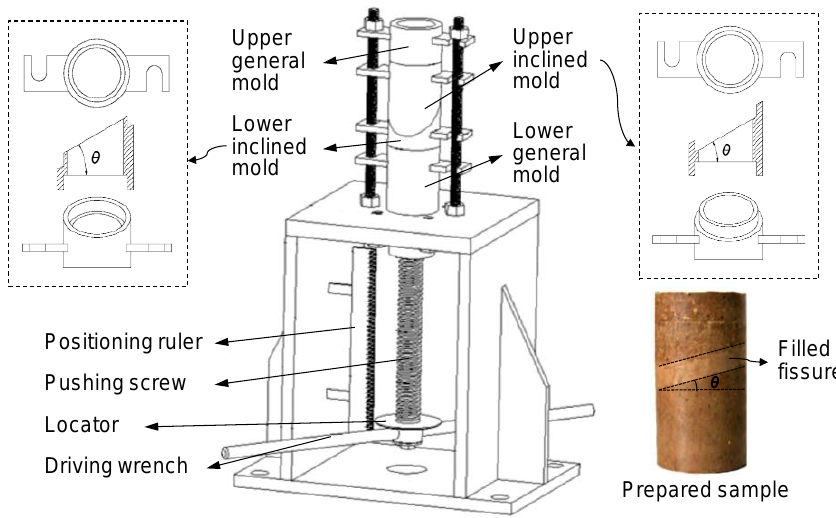
Figure 3. Sample preparation device for triaxial sample with filled fissure.